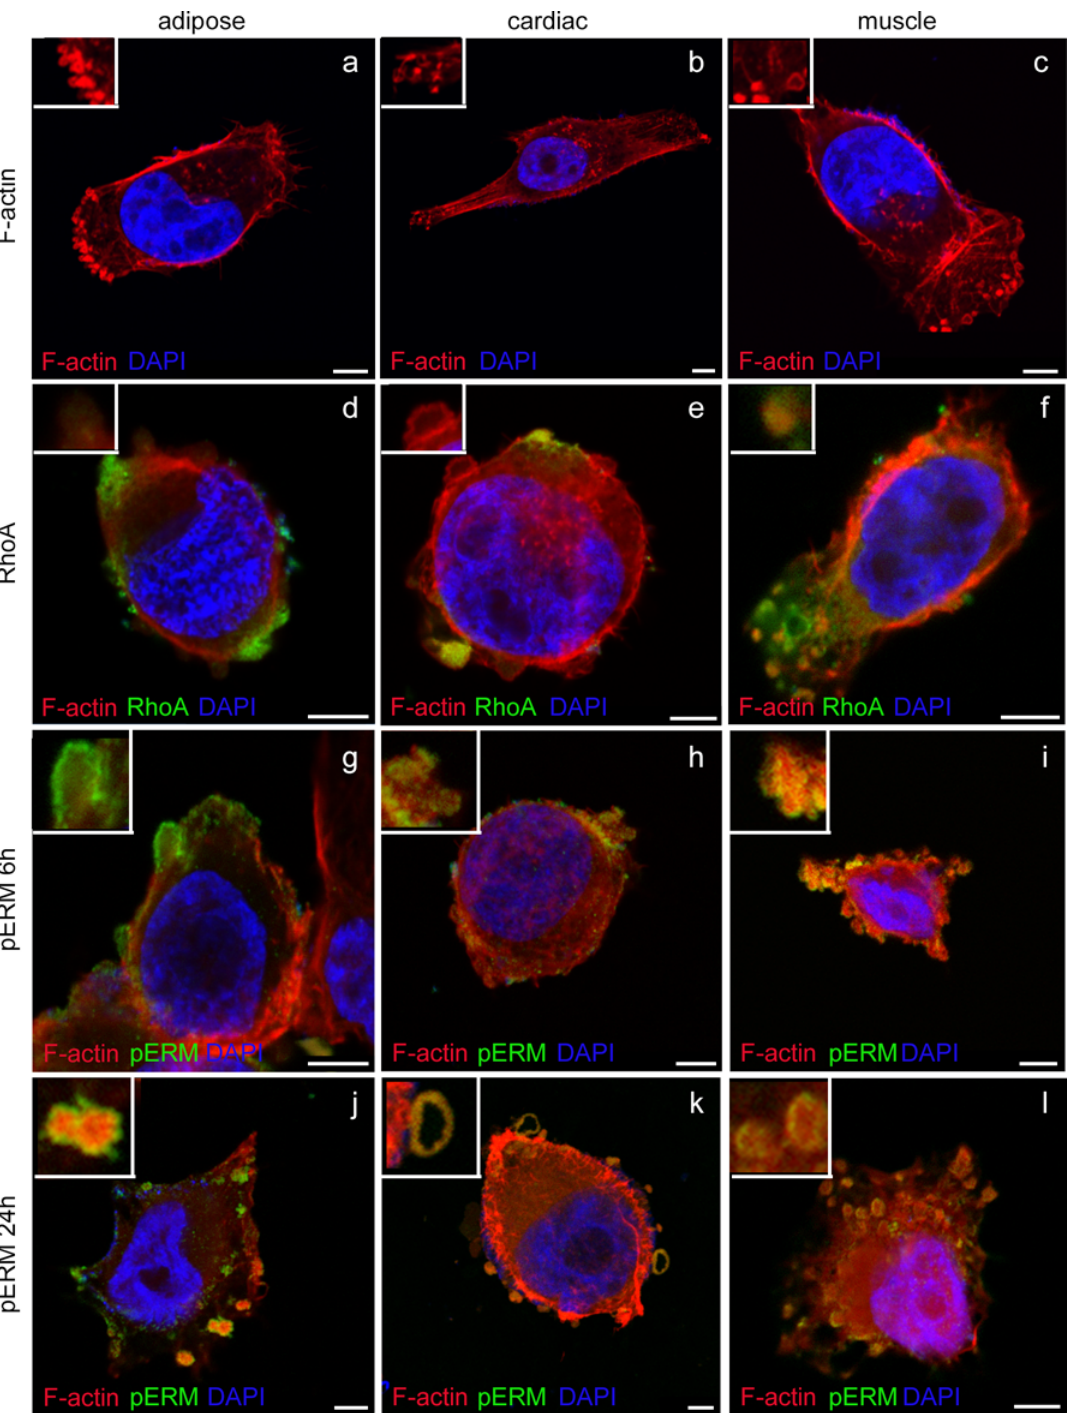
Fig 2. Characterization of bleb structure by immunofluorescence. Confocal images of MPs at 63x using zoom in. Higher magnifications of selected blebs are shown in the upper left corner. All precursors are stained for F-actin (in red) and DAPI (in blue). Cell fixed after 6 hours of seeding the cells were stained for RhoA in green (d-f). Cells were stained for pERM in green at 6 hours (g-i) and 24 (j-l) hours after seeding the cells. Merged of pERM in green, F- actin in red and nuclei in blue at 6h (g-i) and 24h (j-l). Confocal images of MPs at 63x and zoom in. Bar 5 μ m.